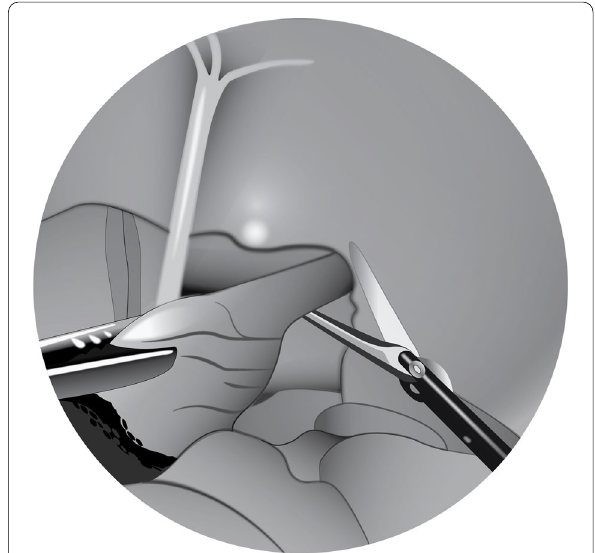
Fig. 2 Illustration of the technique used